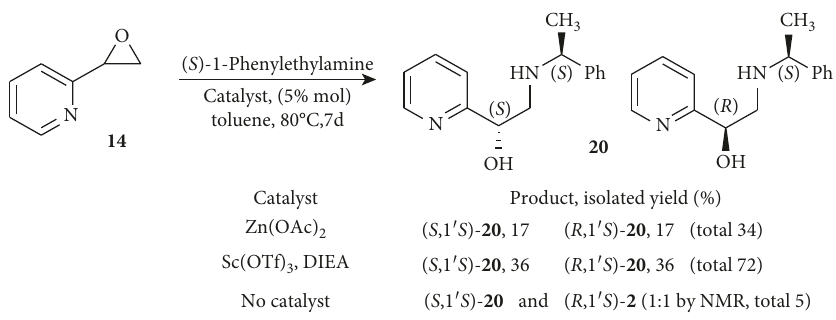
Scheme 3: Ring opening of 2-(oxiranyl)pyridine with ( S (Figure 2) (different configuration descriptors at C5 for (4 R ,5 R ,1 ′ S )- 27 and (4 R ,5 S ,1 ′ S )- 26 arise from CIP rules). The obtained enantiomerically pure pyridine- β -amino al- cohols: ( S ,1 ′ S )- 20 , (1 S ,2 S ,1 ′ R )- 21 , and (1 S ,2 S ,1 ′ S )- 21 and bipyridine- β -amino alcohols: (1 S ,2 S ,1 ′ S )- 23 and (1 R ,2 R ,1 ′ S )- 23